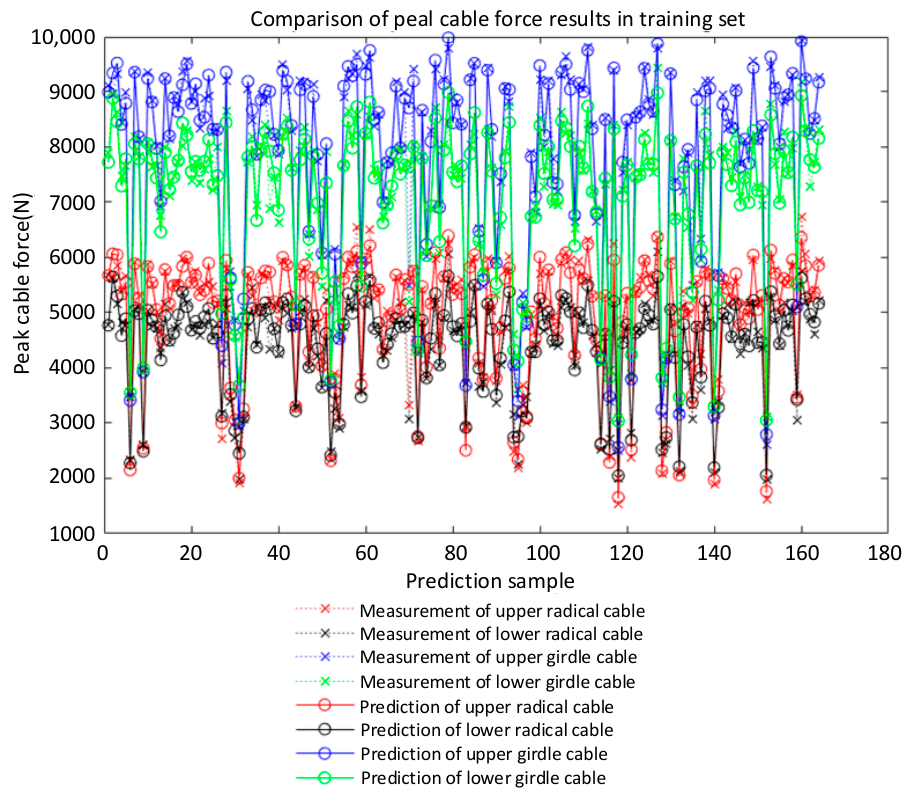
Figure 12. Comparison of prediction results of cable force change rate in the training set. The test took an average of 0.7 h for each working condition (from adjusting the sleeve control cable prestress to conduct the impact test and carrying out data sorting and